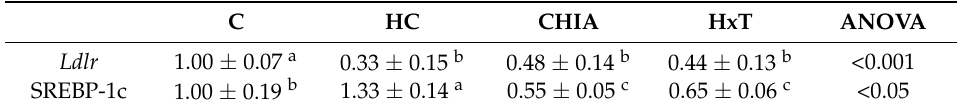
Table 5. Liver Ldlr and SREBP-1c expression.